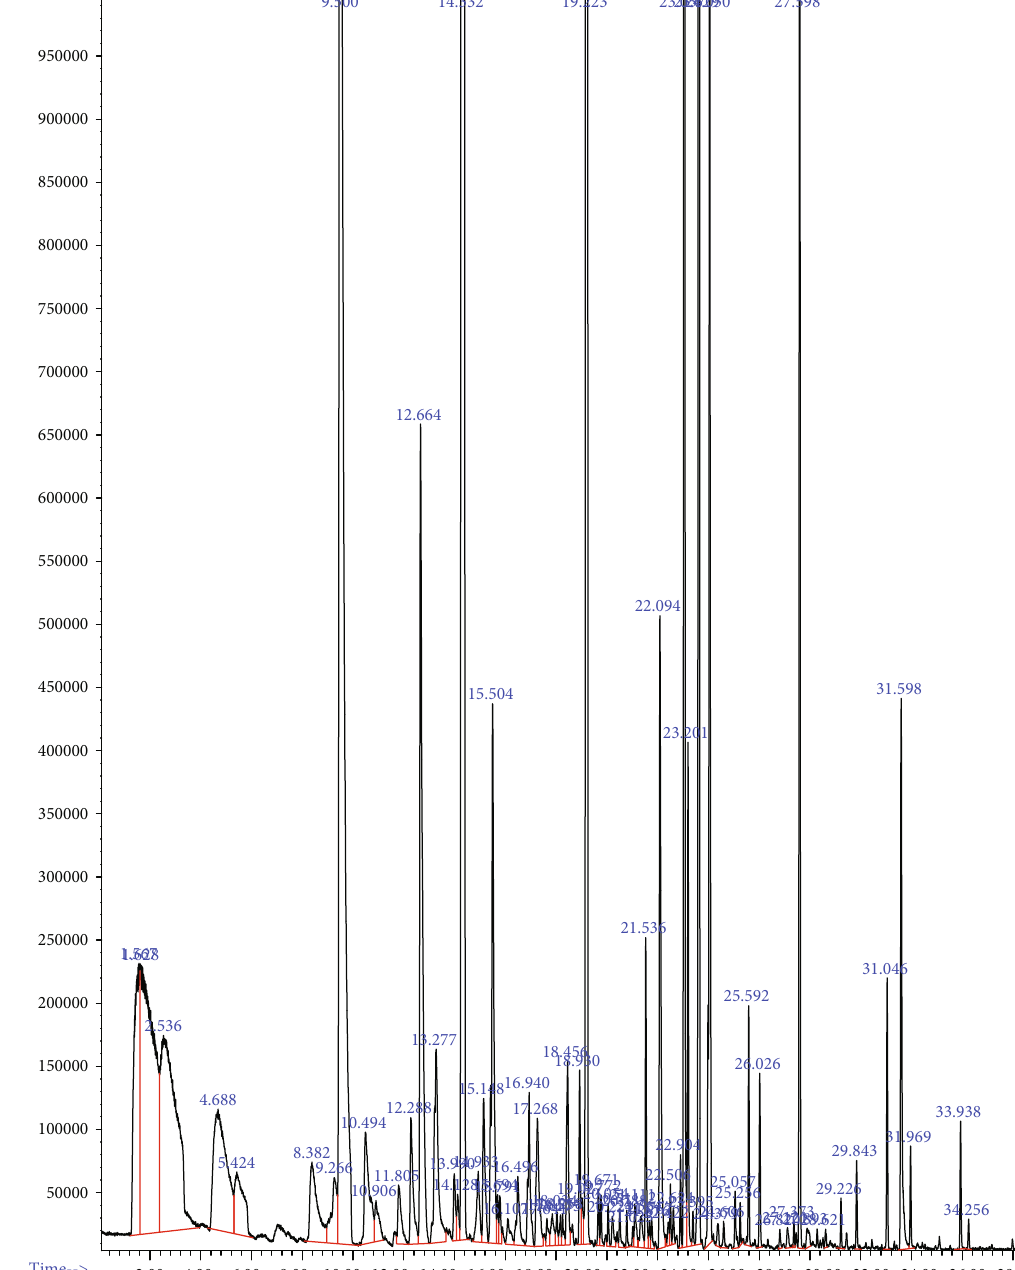
Figure 2: GC-MS chromatogram of the volatile compound of tyrosinase and β -glucosidase-treated tea